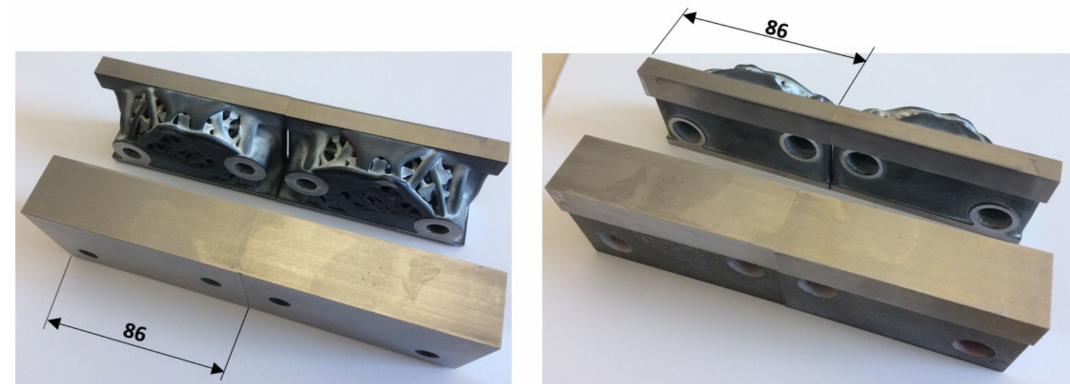
Figure 11. The 3D-printed (L-PBF) solid and topology optimized trimming tools. Both versions were 3D-printed (L-PBF) in DIN 1.2709 [131]. All displayed dimensions are in mm.